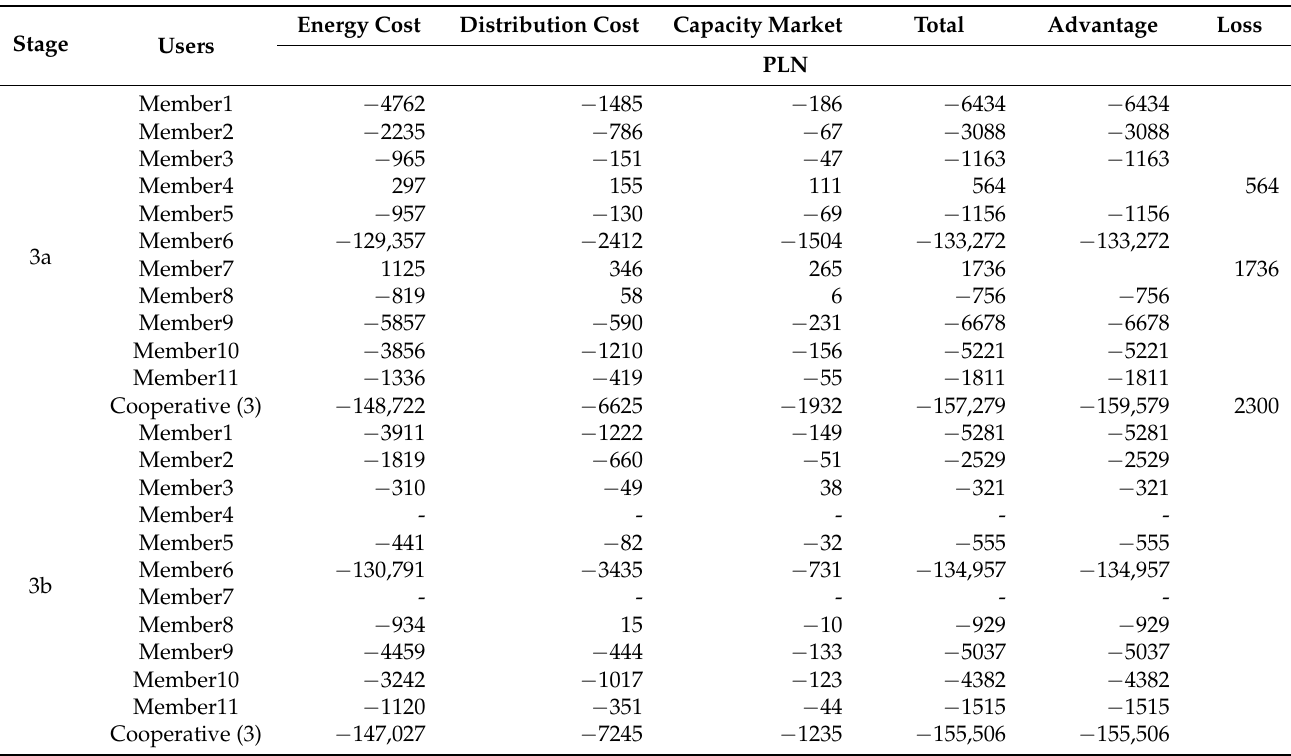
Table 7. Decomposition of the cooperative’s result into its